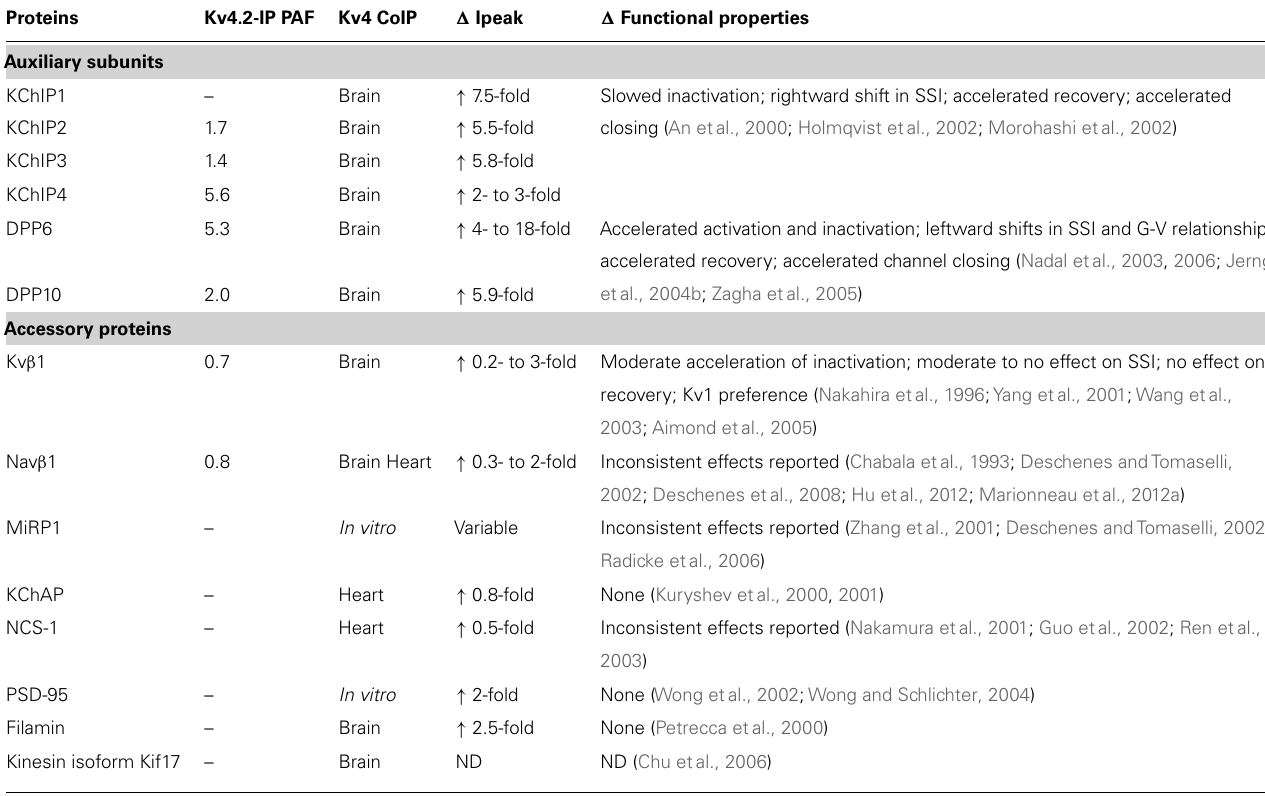
Table 1 |Validation of auxiliary subunits and accessory proteins.